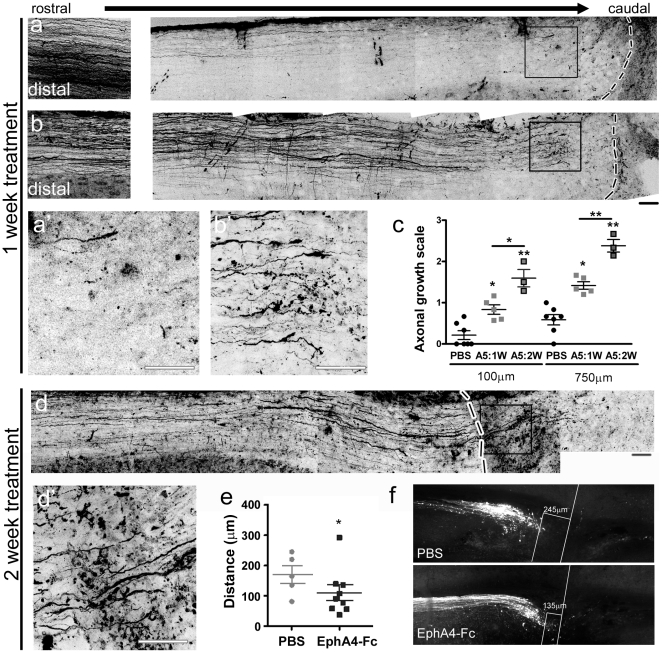
Axonal regrowth towards the lesion site in ephrin-A5-Fc-treated spinal cords 2 weeks after injury.A montage of confocal images 2 weeks after injury from representative sections anterogradely traced with Fluoro-ruby showing that (A) PBS-treated mice had few labeled axons rostral to the lesion site and that (B) one week of ephrin-A5-Fc treatment increased the number of axons proximal to the lesion site. Axons in the ephrin-A5-Fc-treated mice had robust growth cones. Boxes show enlarged regions in a′ and b′. Scale bars for A, B, A′, B′, 50 µm. Dotted lines in A, B indicate the border of the lesion site and the right hand side of panels is caudal to the lesion site (C) Axonal regrowth was determined by semi-quantitative analysis of axons 100 µm or 750 µm rostral to the lesion site after ephrin-A5-Fc (A5) treatment for 1 week (1 W) or 2 weeks (2 W): ordinal scale 0 = no axons; 1 = fewer than 10 axons; 2 = 10–50 axons; 3 = more than 50 axons per section (from n≥5 sections per spinal cord). *p<0.05, **p<0.01, ***p<0.001 compared to the PBS-treated control, using one-way ANOVA with Tukey's multiple comparison test. (D) Two weeks treatment with ephrin-A5-Fc promoted substantial axonal regeneration into the lesion site; box enlarged in D′. Scale bars D, D′, 50 µm. (E) Regrowth of labeled corticospinal tract axons towards the lesion site at 2 weeks, after 2 weeks EphA4-Fc treatment, with distance from center of injury site; *p<0.05. (F) Representative images of labeled corticospinal tract axons 2 weeks after injury, and a 2-week treatment protocol, showing distance to the center of the injury site.